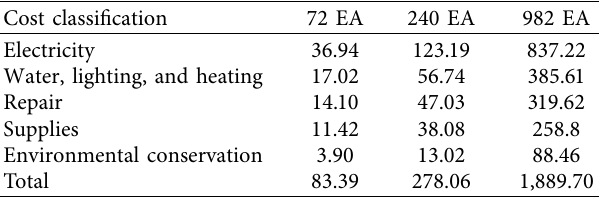
Table 4: CO 2 emissions of in-plant operation factors.